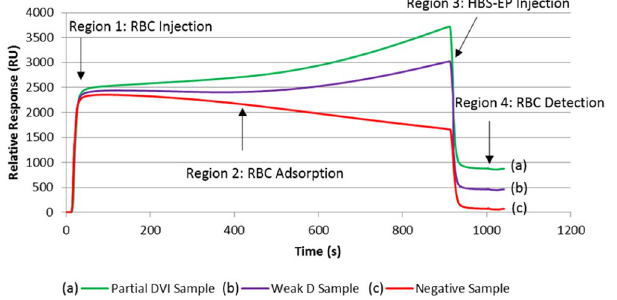
Figure 1. SPR sensogram presenting the injection of RBC over a IgG antibody functionalised sensor surface, and the difference in relative binding response when compared to steady-state running buffer. Depicted here, are ( a ) a partial DVI sample, and ( b ) a weak D sample compared to that of ( c ) a negative sample. Presensitised RBCs were washed 4 times prior to being injected at 10% concentration (v/v) in Celpresol LISS at a rate of 1 µ L min − 1 for 15